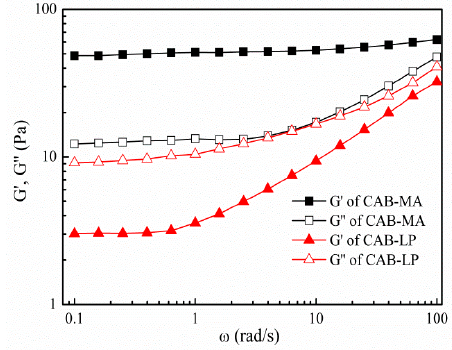
Figure 4. The dynamic frequency scanning curves of the CAB-MA and CAB-LP.